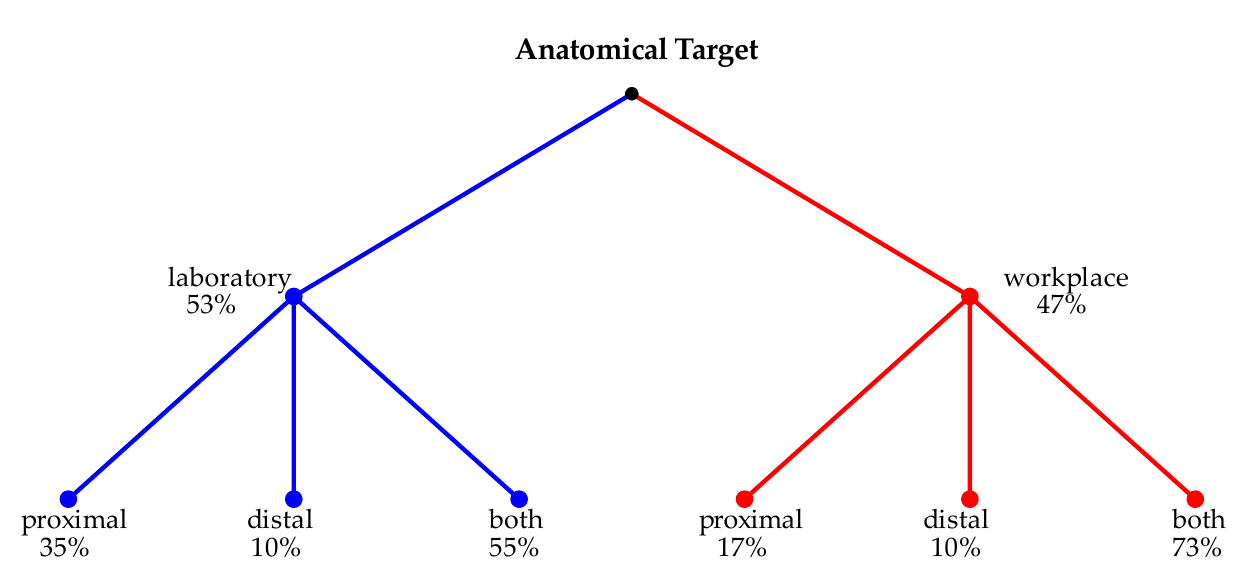
Figure 8. Anatomical targets considered in the laboratory setting ( on the left ) and in the workplace setting ( on the right ).